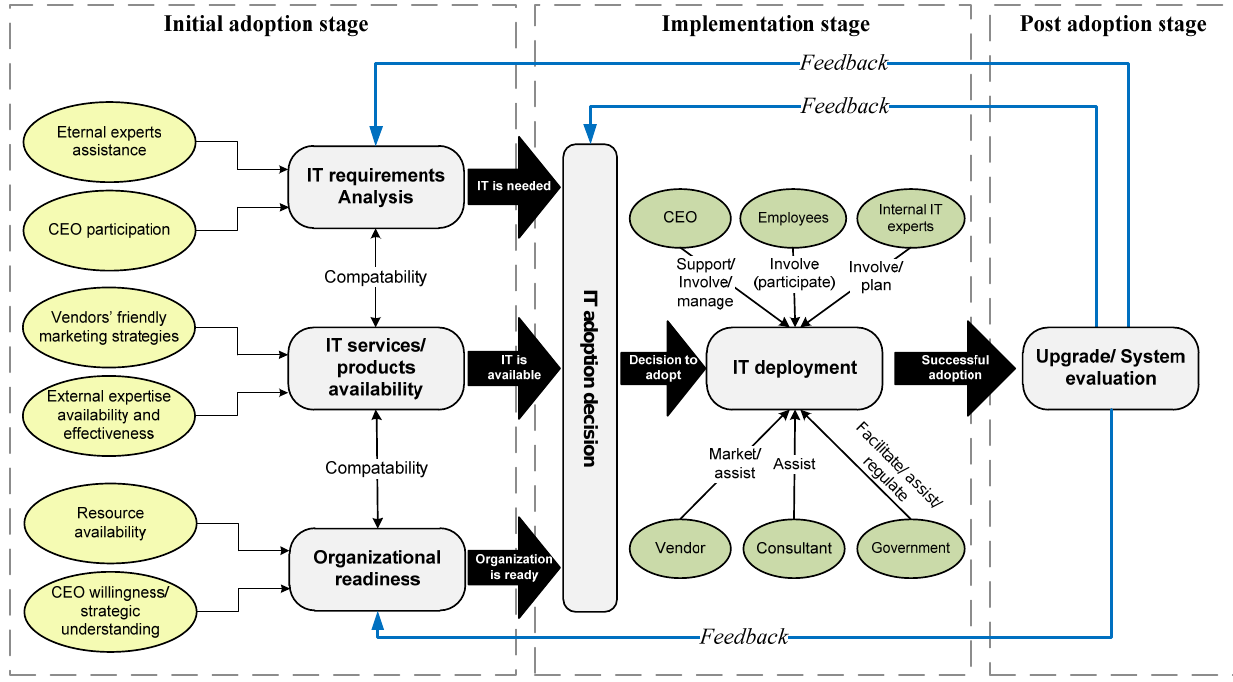
Figure 2. Conceptual model of effective IT adoption process within